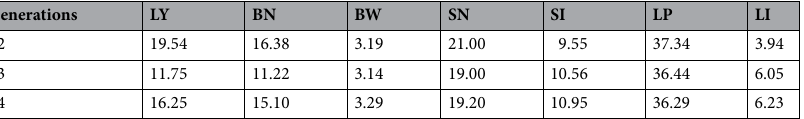
Table 7. Means of lint yield/plant (LY), boll number/plant (BN), boll weight (BW), seed number/boll (SN), seed index (SI), lint % (LP), and lint index (LI) for the three generations.